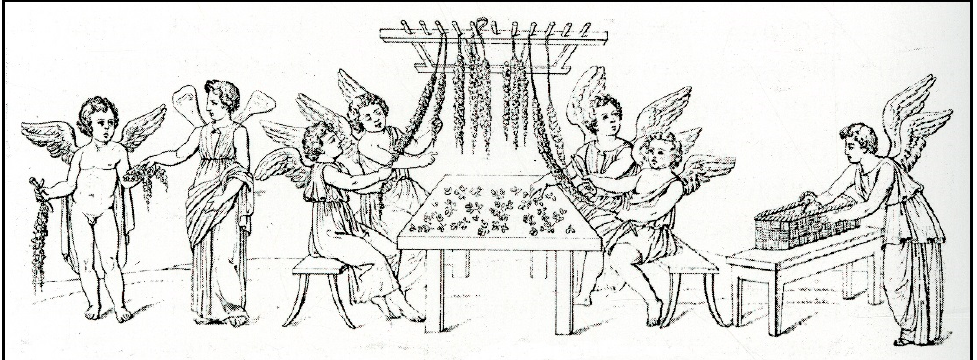
Figure 2. Flower dealer fresco (7.9.7). Pompeii. Cupids making garlands in the center. (Modified by author, after Jashemski 2018, Figure 4.23A).